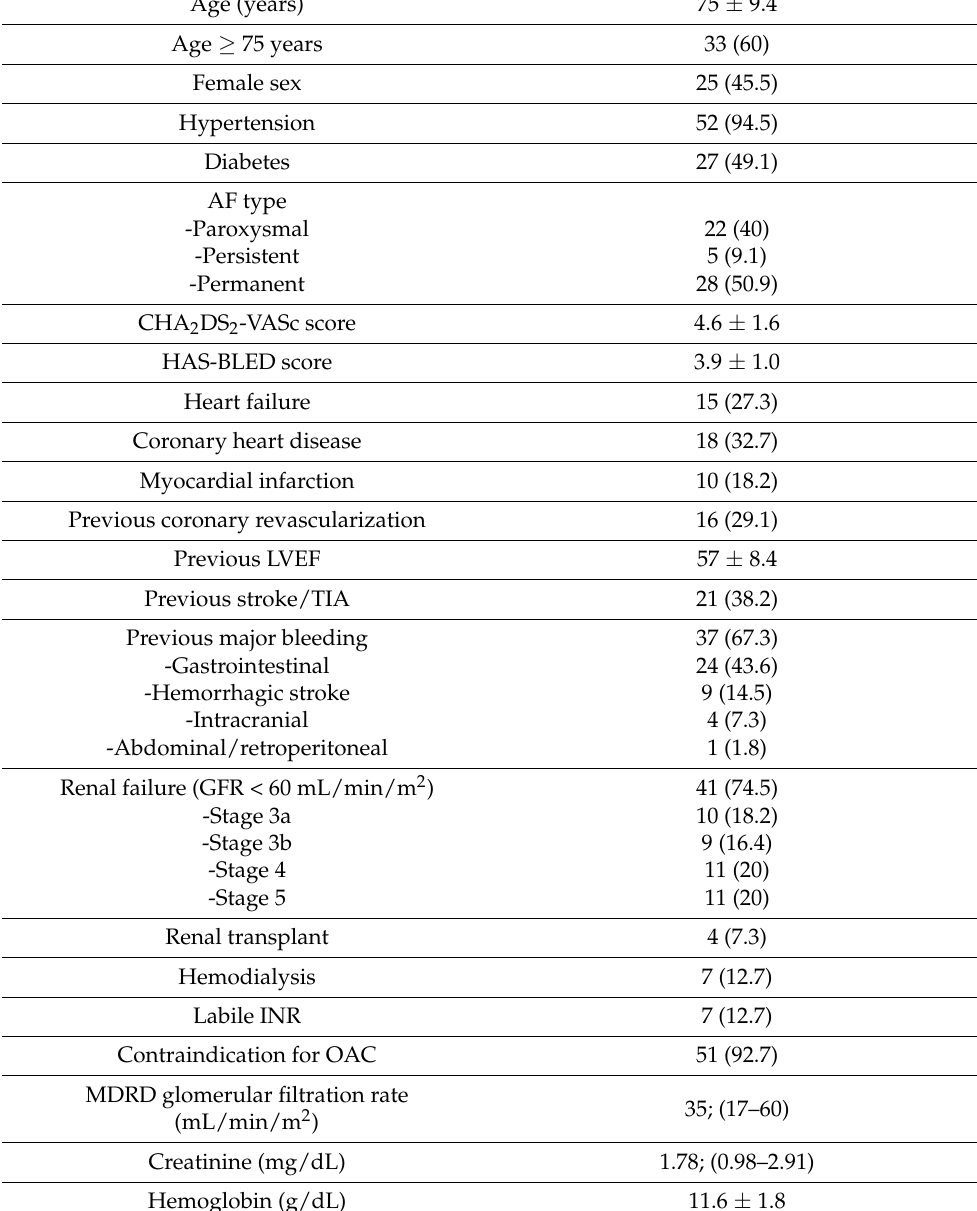
Table 1. Baseline characteristics ( n =